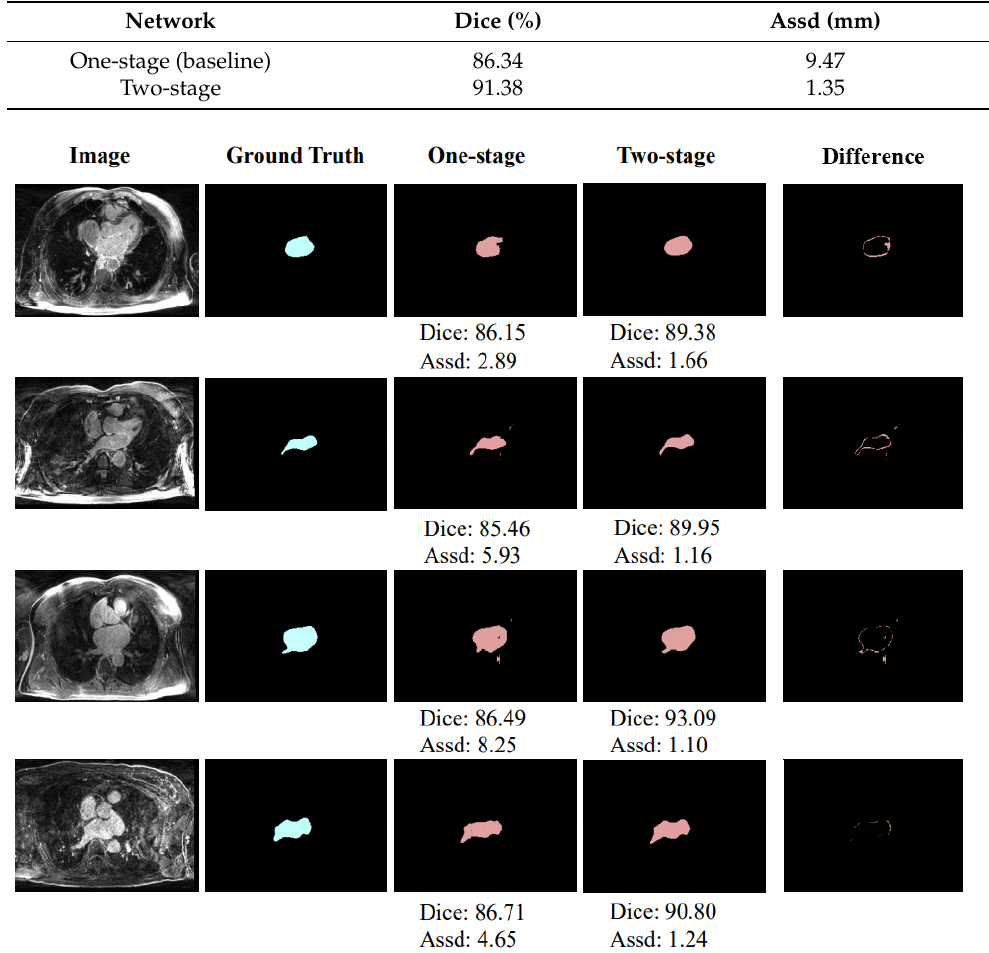
Table 1. Performance comparison between one-stage network and two-stage network.